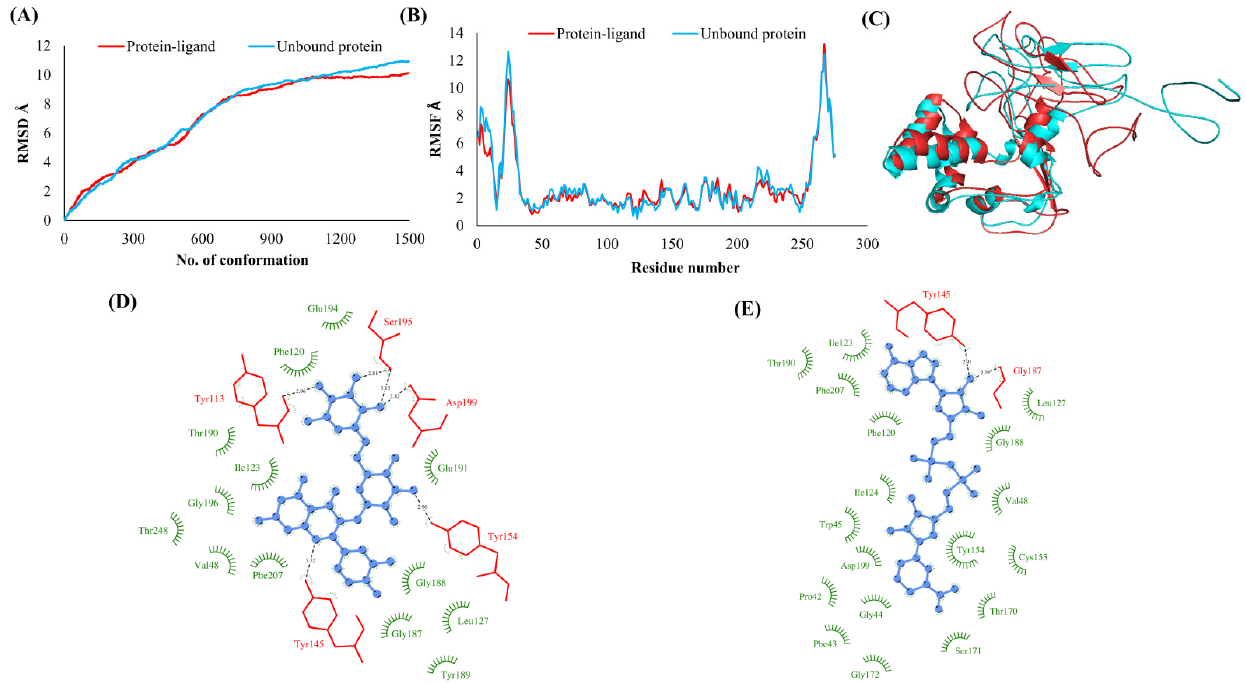
Figure 8. ORF 3a. ( A ) RMSD plot of unbound and ligand-bound protein ( B ) RMSF plot of unbound and ligand-bound protein ( C ) Superimposition of unbound and ligand-bound protein ( D ) Molecular interactions of protein with Rutin ( E ) Molecular interactions of protein with NADH.